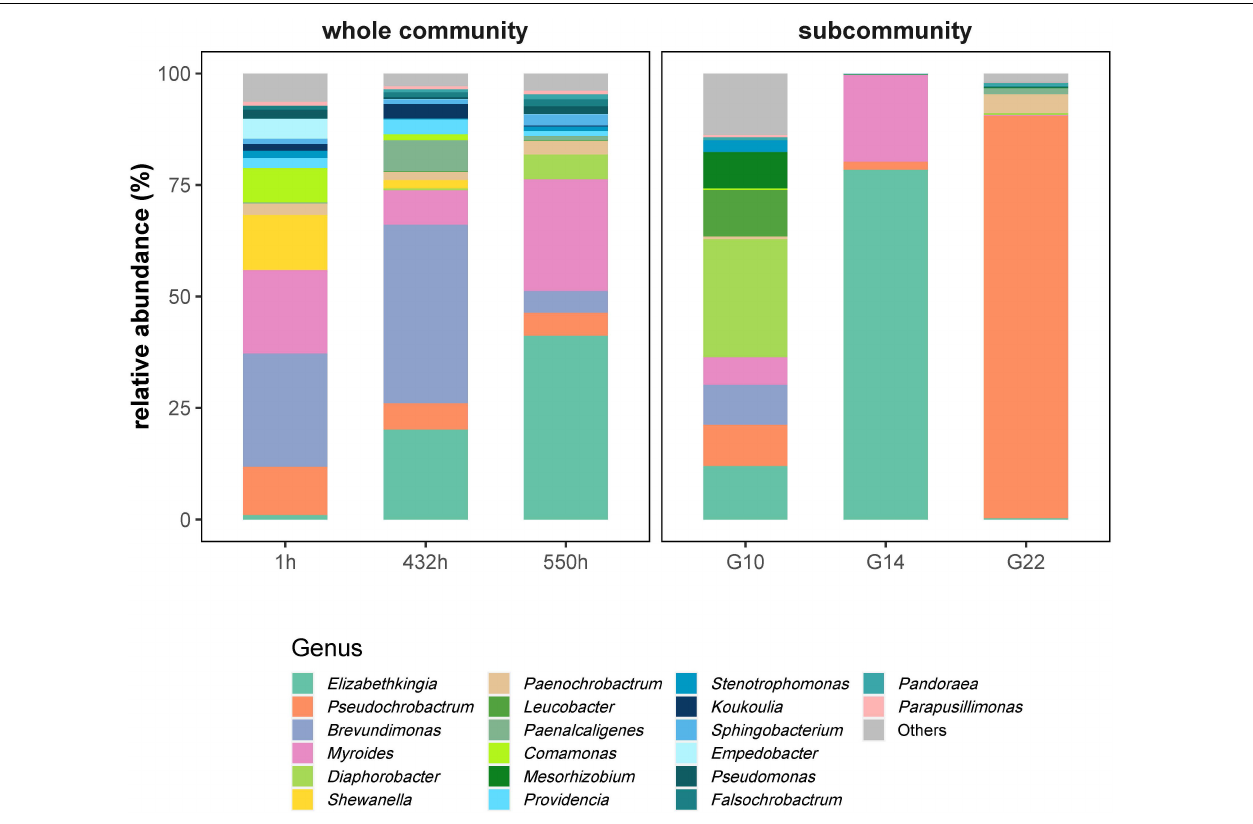
FIGURE 4 | The relative abundances (%) of genera in whole communities and sorted subcommunities. Whole communities at 1 h (starting time point of phase 1: adaptation), 432 h (starting time point of phase 4: 268 mg L − 1 fosfomycin), and 550 h (a middle time point of phase 4: 268 mg L − 1 fosfomycin). Subcommunities G10, G14, and G22 sorted from 550-h community. G10, G14, and G22 were persistent over phase